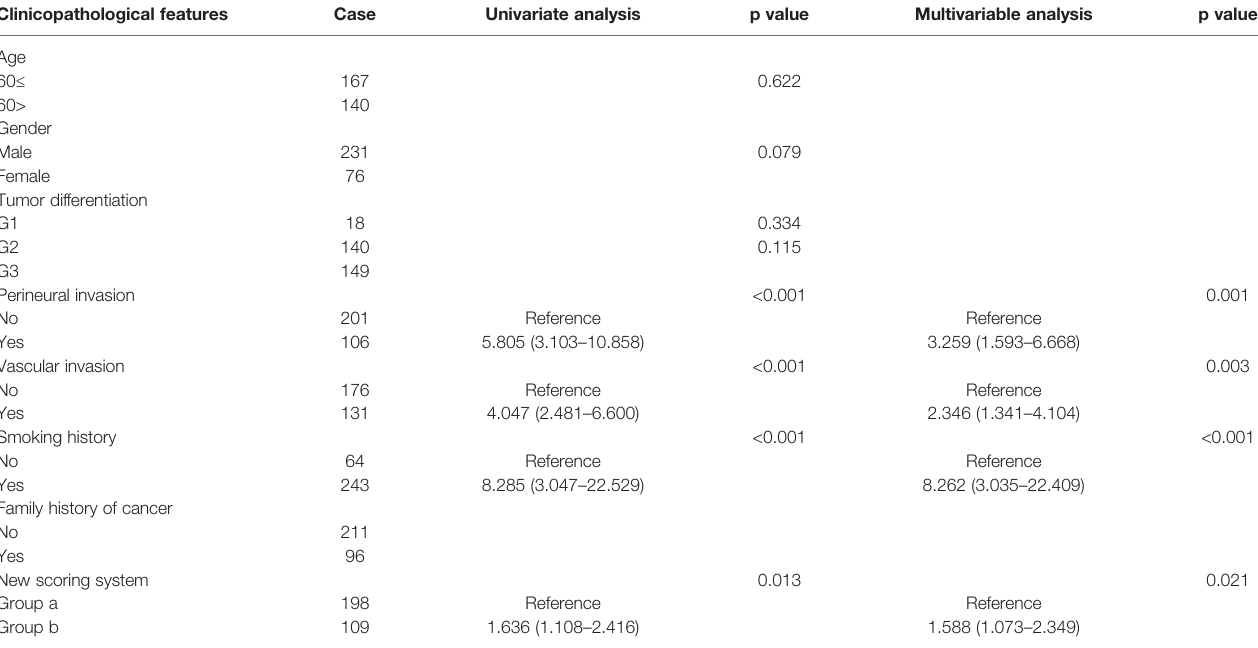
TABLE 3 | Univariate analysis and multivariable analysis of clinicopathologic variables in relation to RFS. Clinicopathological